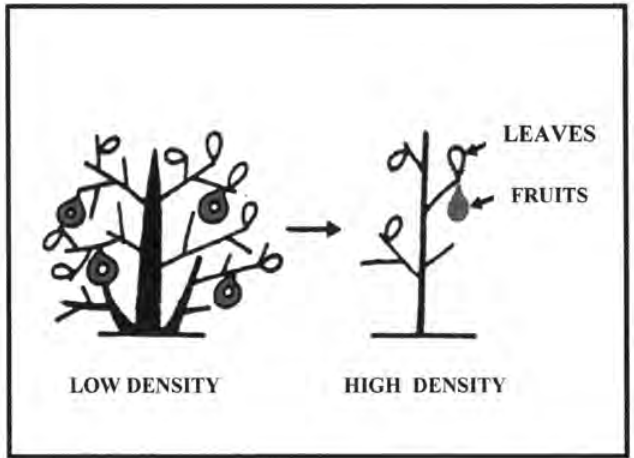
Fig. 10 - Effect of planting density on tree structure. Closely planted trees bear more fruits per unit canopy volume than widely spaced trees because of phenotypic plasticity (Cannel,